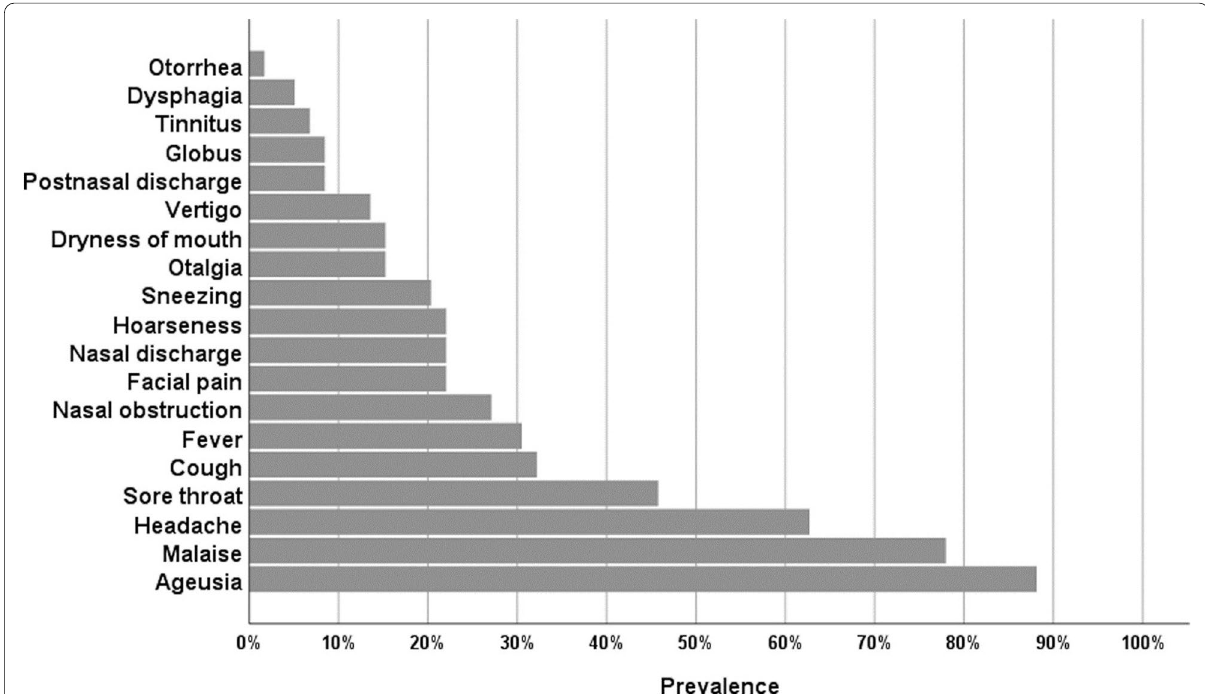
Fig. 1 Prevalence of associated symptoms in the study